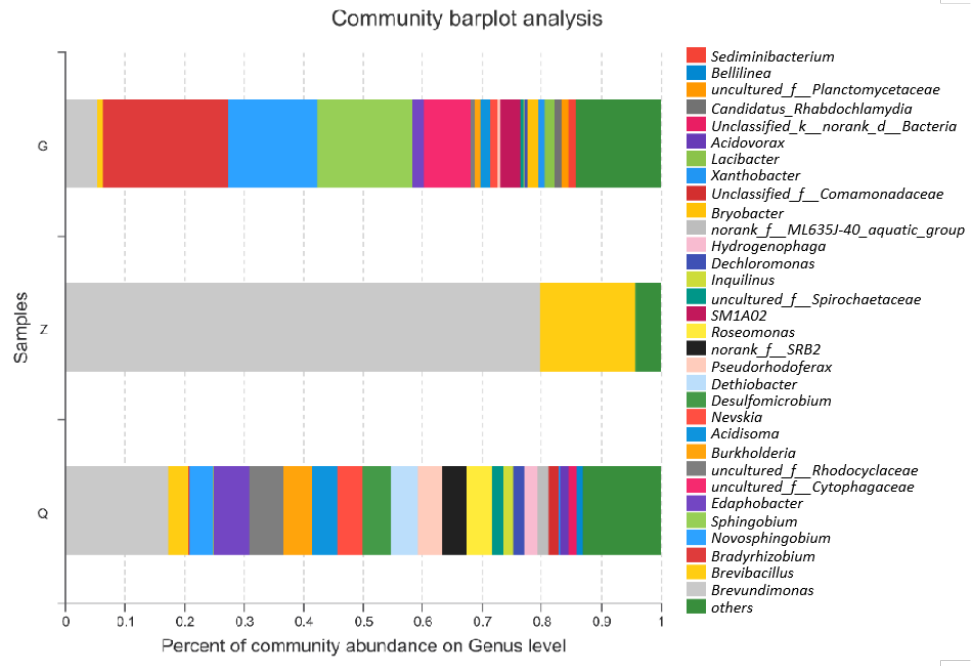
Figure 5. Taxonomic distribution of phylogenetic groups for biofilms from SP, CI, and DI at the genus level.